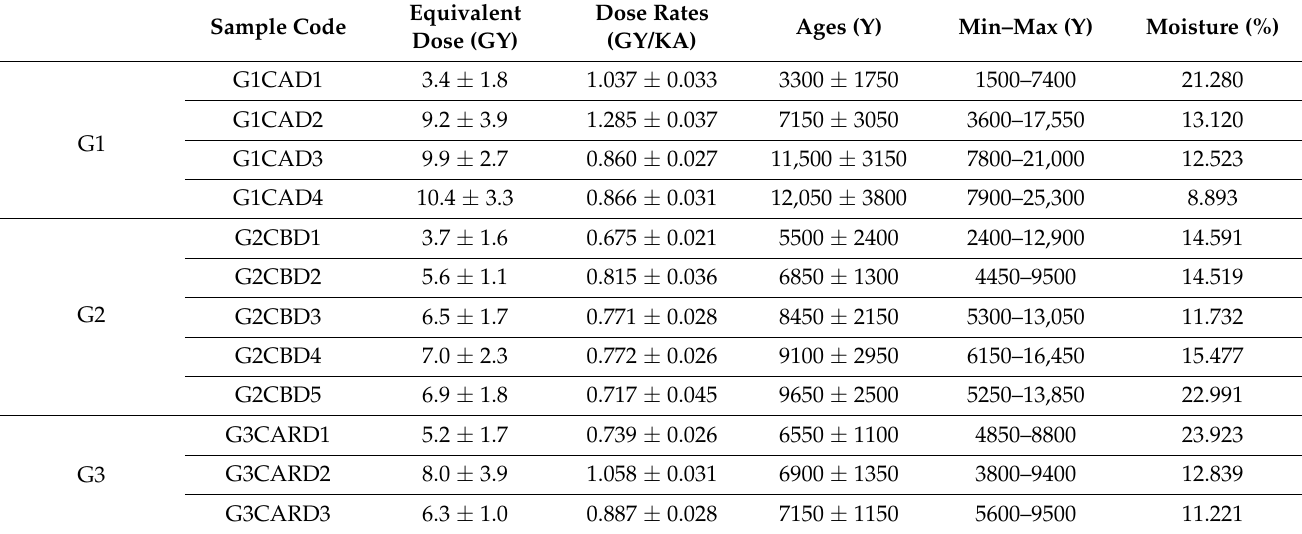
Table 7. Equivalent doses, dose rates, and calculated ages in y before